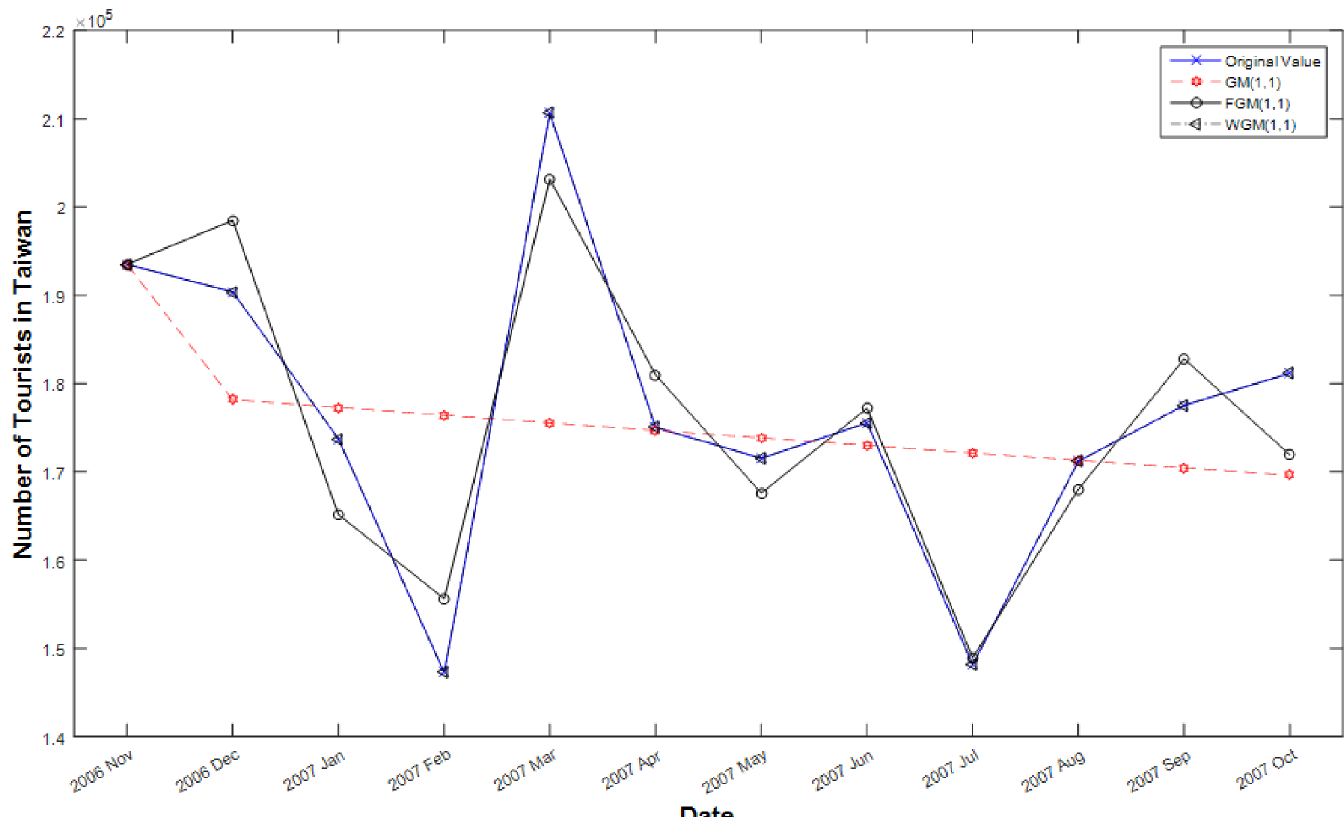
Fig 3. Line graphs of simulated values after processing of the three